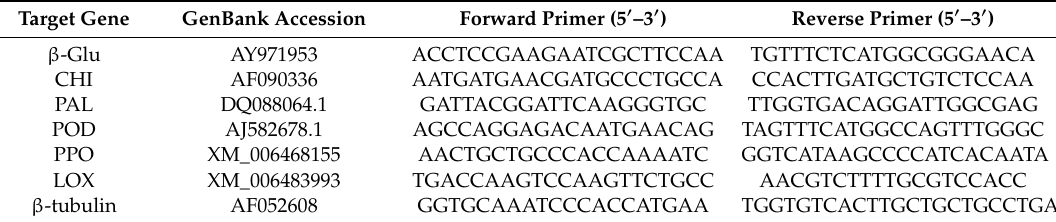
Table 1. Primers used for real time-quantitative polymerase chain reaction (RT-qPCR) of key defense-related genes in citrus